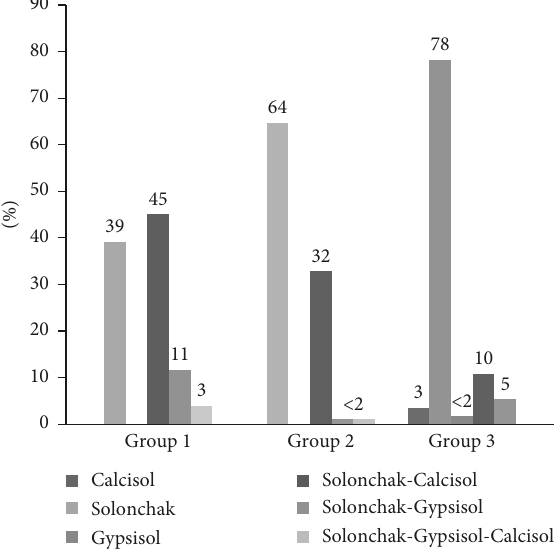
Figure 9: Histogram of soil group frequencies and their